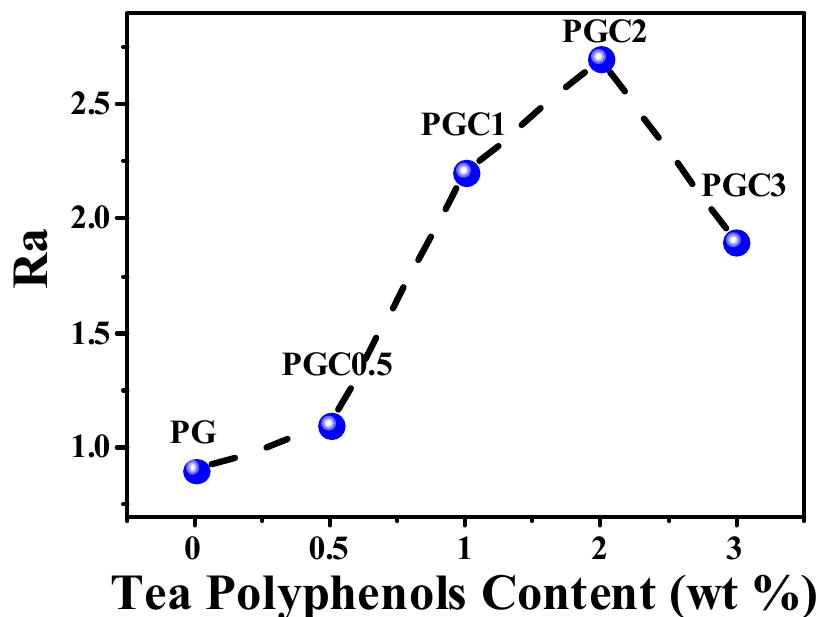
Figure 9. Schematic illustration of the graft reaction of tea polyphenols (C) and GMA onto polypropylene.